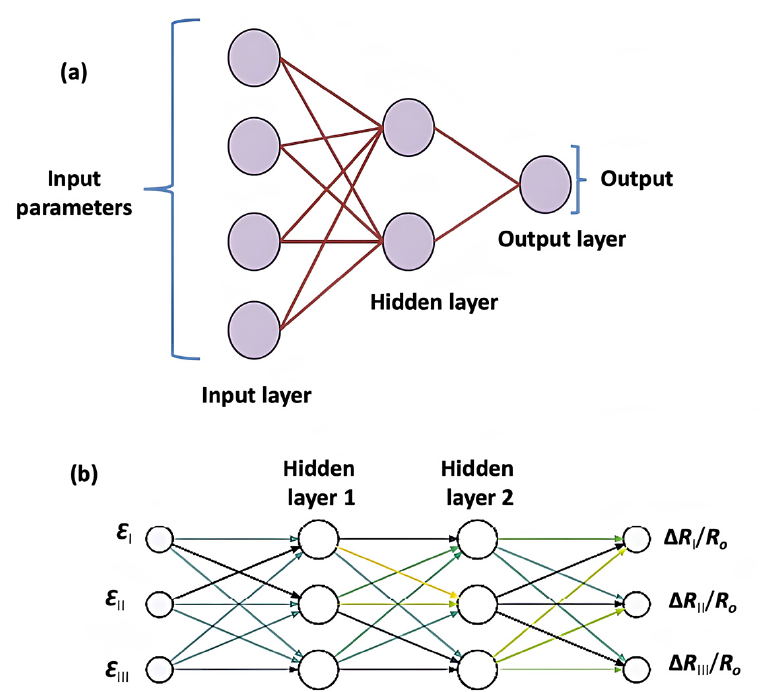
Figure 14. ( a ) Scheme of the artificial neural network (ANN) basic architecture with input, hidden and output layers to receive the preprocessed data, compute the correlations and give the predicted output, respectively. ( b ) ANN for predicting the electro-mechanical response of polymer/CNT nanocomposites.